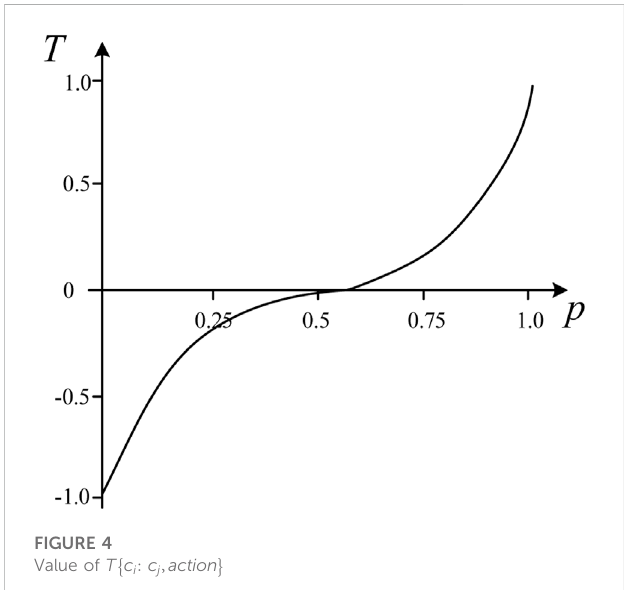
FIGURE 4 Value of T c i : c j , action